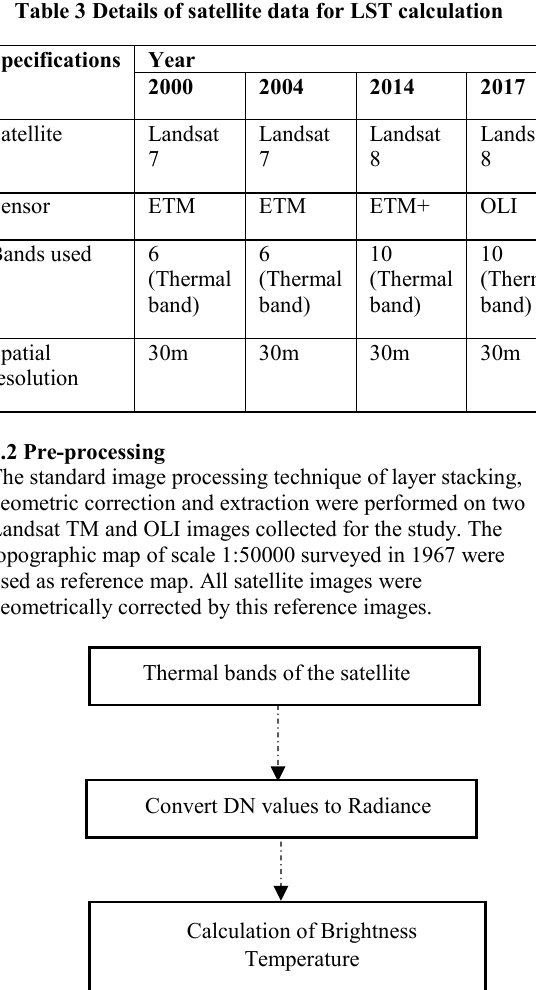
Figure 3 Scheme adopted for Brightness